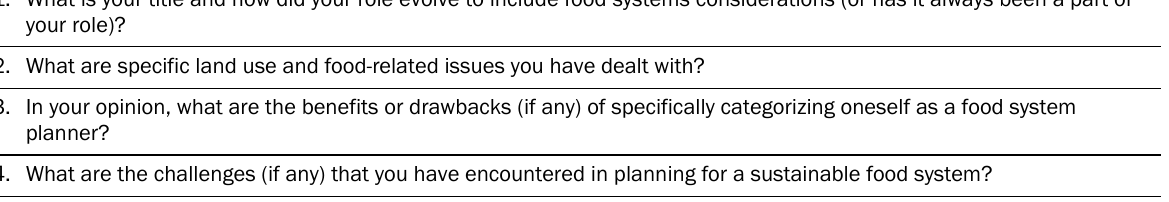
Table 1. Interview Core Questions